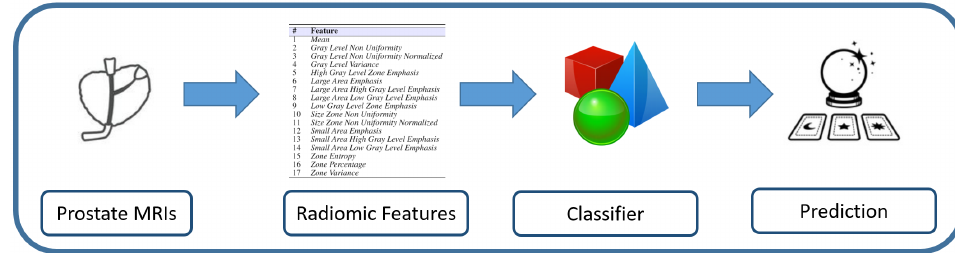
Figure 2. Testing phase.